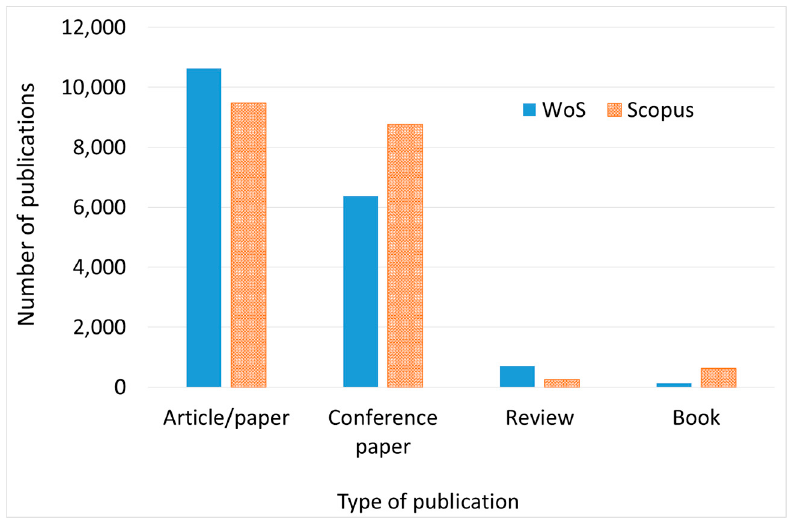
Figure 1. Document type distribution during the period January 2013–September 2019.